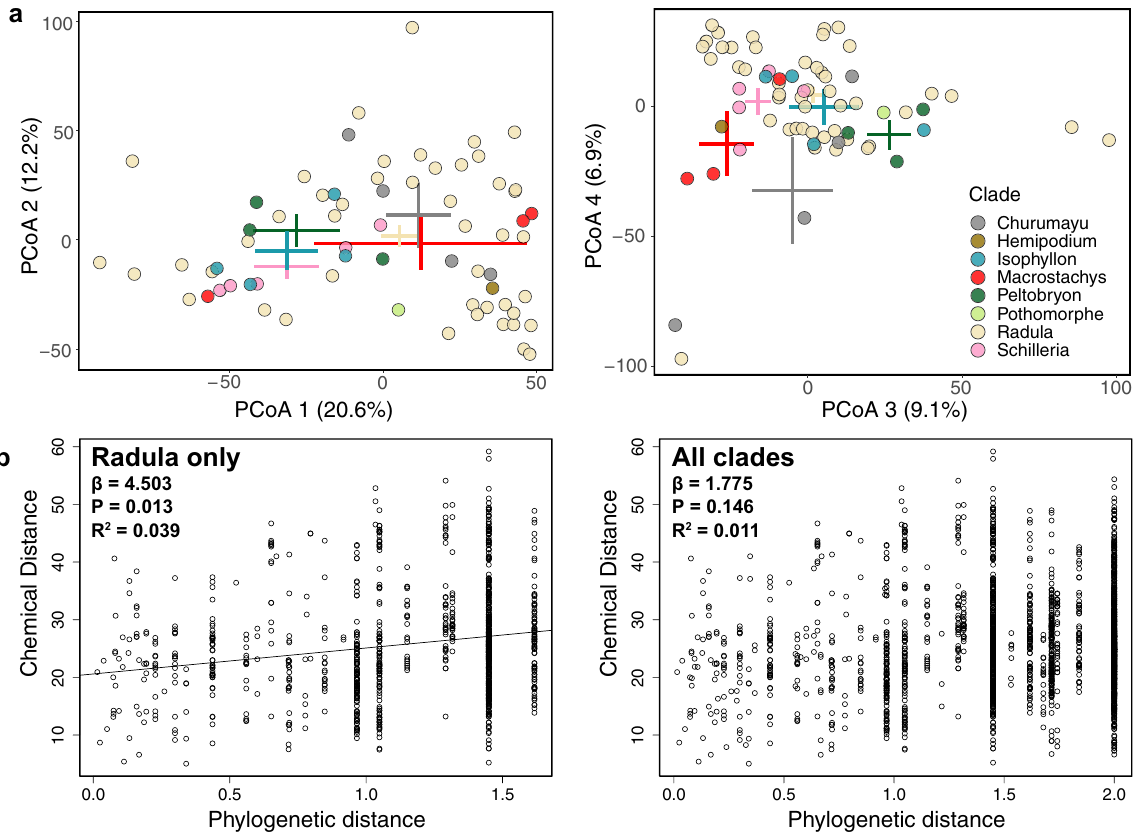
Figure 4. ( a ) Chemospace of all 67 Piper samples constructed with the crude 1 H NMR data across 263 peaks. Point colors were chosen according to clade designation as portrayed in the phylogenetic tree in Fig. 1. A legend is provided in the rightmost PCoA plot. Error bars depict estimates of ordination mean + /− 3 standard errors for each clade. ( b ) MRM analyses recovered a significant positive relationship between phylogenetic and chemical distances calculated among samples from the Radula clade (left), but did not recover a significant relationship when calculated among all samples from all clades